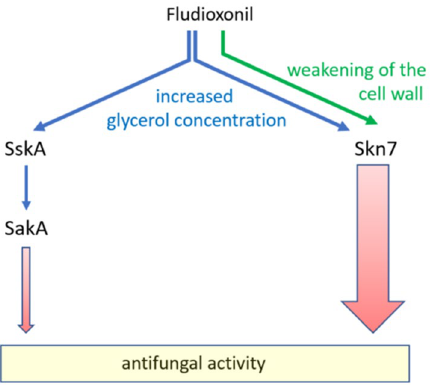
Figure 9. Schematic model of the proposed mechanisms mediating the antifungal activity of fludioxonil in A. fumigatus. Blue arrows: increase in the internal glycerol concentration. Green arrow: Weakening of the cell wall. Red arrows: The relative contribution of Skn7 and the SskA-SakA axis to antifungal activity of fludioxonil is indicated by the width of the respective